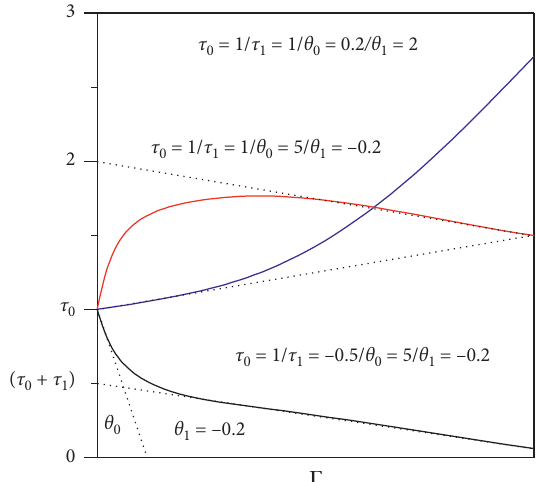
Figure 1: Meaning of parameters in voce